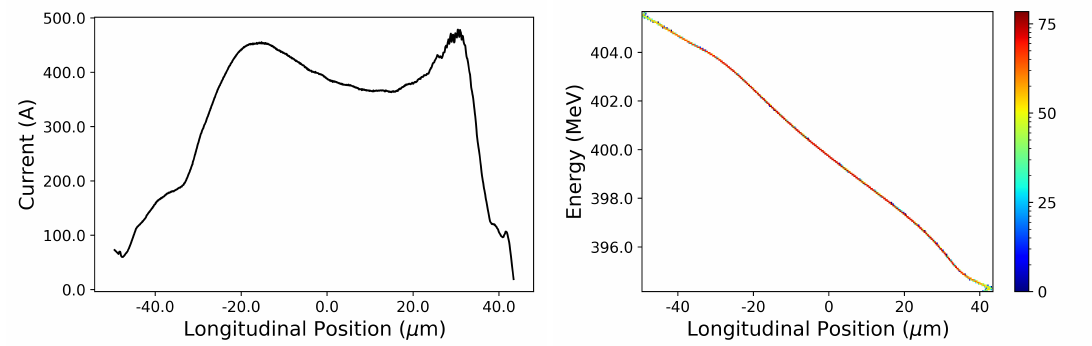
Figure 4. On the left, the current profile after the first compressor is shown. On the right, the longitudinal phase space is plotted. In both plots the beam head is to the right.